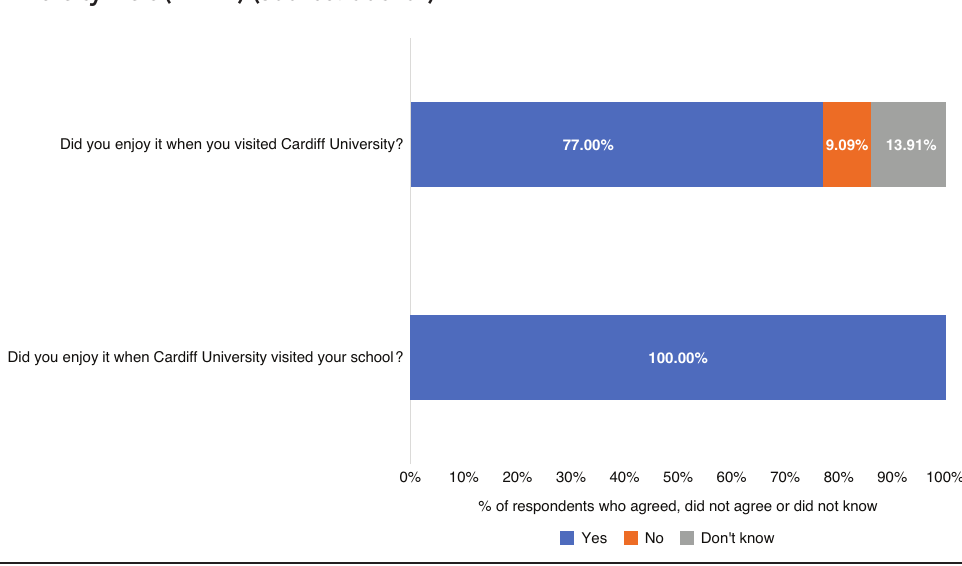
Figure 6: Post-project questionnaire completed by one school following the university visit (N=22) (source: author)